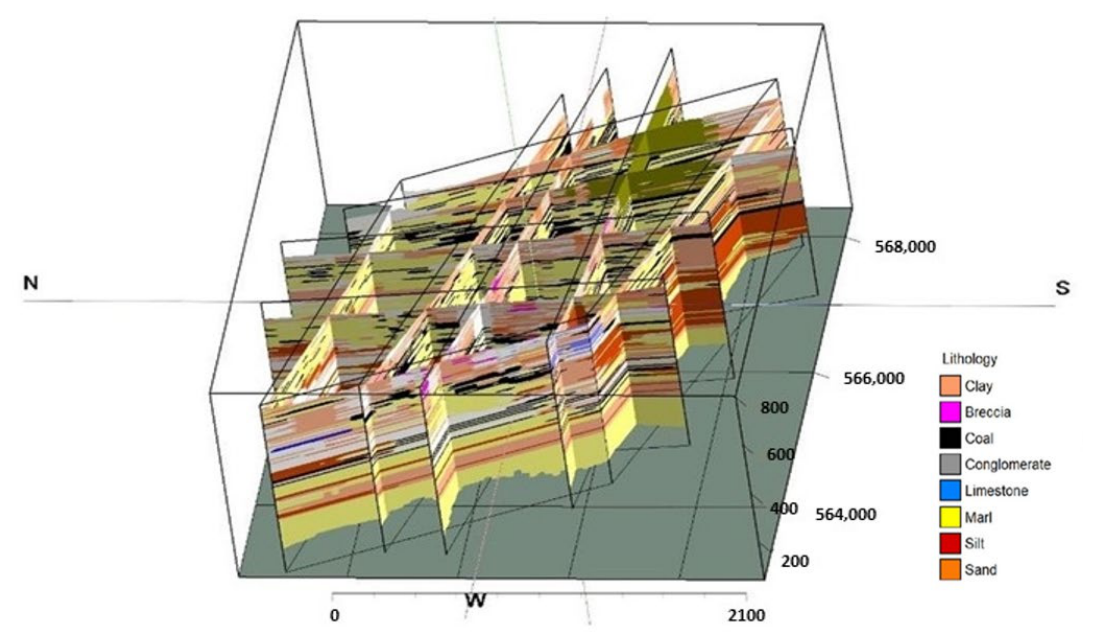
Figure 10. Grid lithology fence panels (Horizontally and vertically; 262°/400) are displayed in 3D using the background colors based on the lithology patterns.